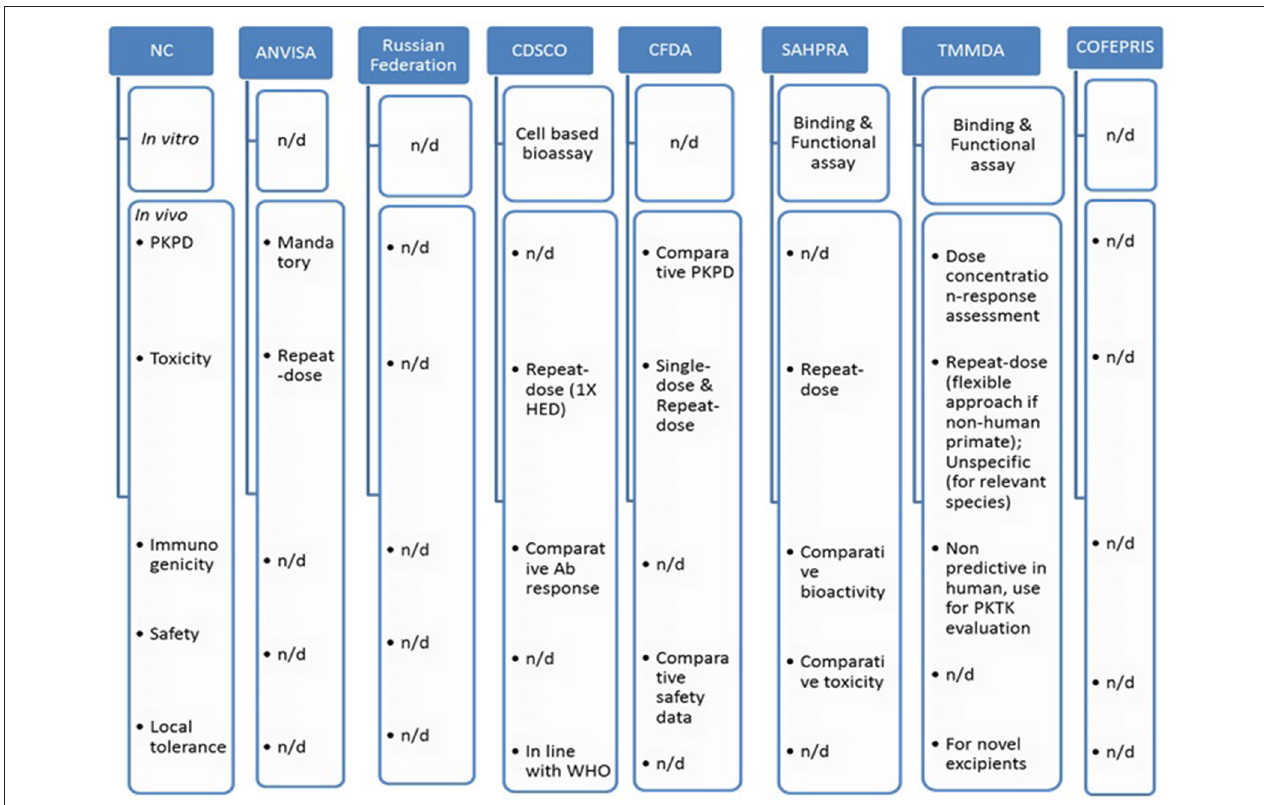
FIGURE 3 | Comparative non-clinical attributes across BRICS-TM markets. n/d, not defined; HED, human equivalent dose; PKTK, pharmacokinetics